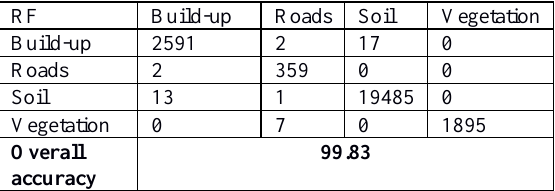
Table 1. Accuracy of predicted materials by RF classification technique.